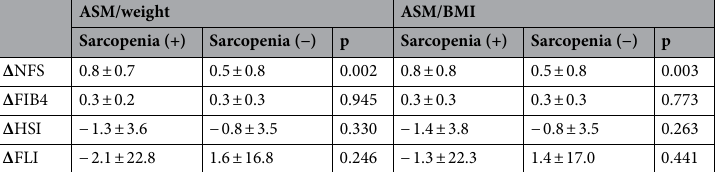
Table 4. Changes in liver-related indices for 6 years according to the baseline sarcopenia status (Bold: p value < 0.05). ASM Appendicular skeletal muscle mass, BMI Body mass index, NFS NAFLD Fibrosis